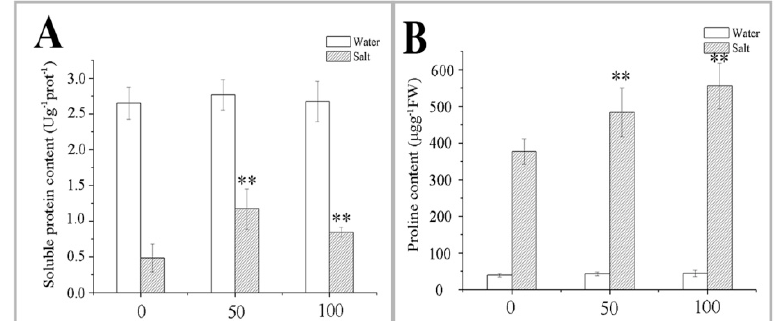
Figure 5. Effect of pretreating with different concentrations of melatonin (MT) on the changes of osmotic adjusting substances in leaves of naked oat seedlings under salt stress. Soluble protein content ( A ); and proline content ( B ).Values are mean ± standard deviation ( n = 3). 0, 50, and 100 represent MT concentration ( µ M) in Figure 5. Asterisks; * and ** indicate significant difference ( p < 0.05 and p < 0.01) compared with mock coating (0 µ M). Measurement was carried out after six days of the salt plus MT pretreatmemt.